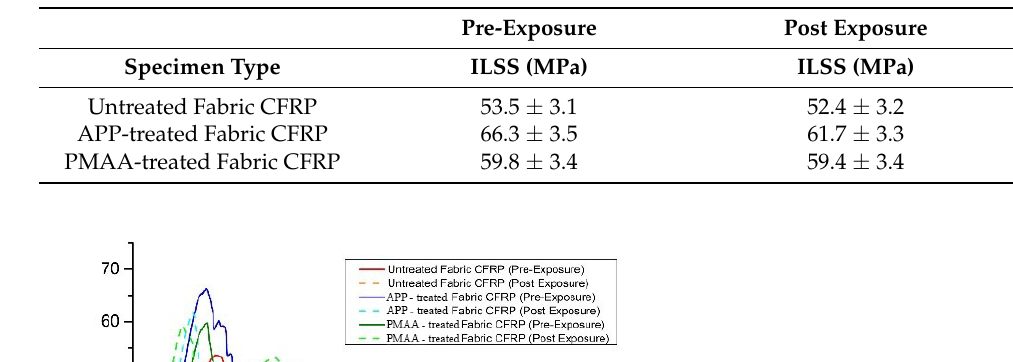
Figure 5. Fracture mechanism observation during short-beam test. Table 8. ILSS of composite materials pre- and post-exposure (Number of specimens tested: 5).